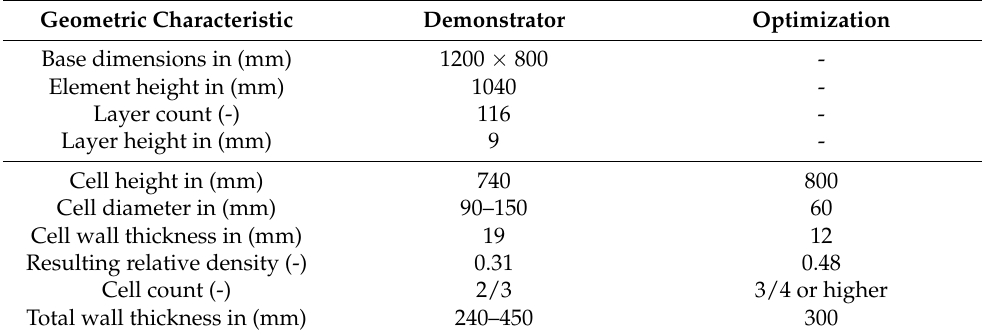
Table 4. Geometric characteristics of the manufactured demonstrator and for a thermally optimized cell